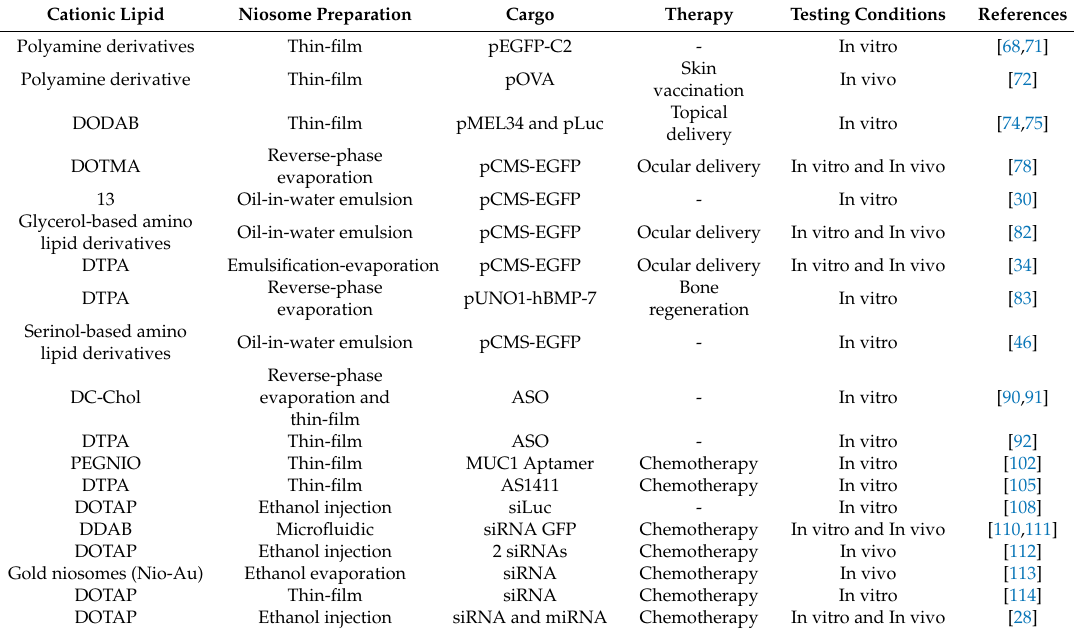
Table 2. Niosome-based non-viral vehicles designed to delivery genetic material inside cells. Cationic Lipid Niosome